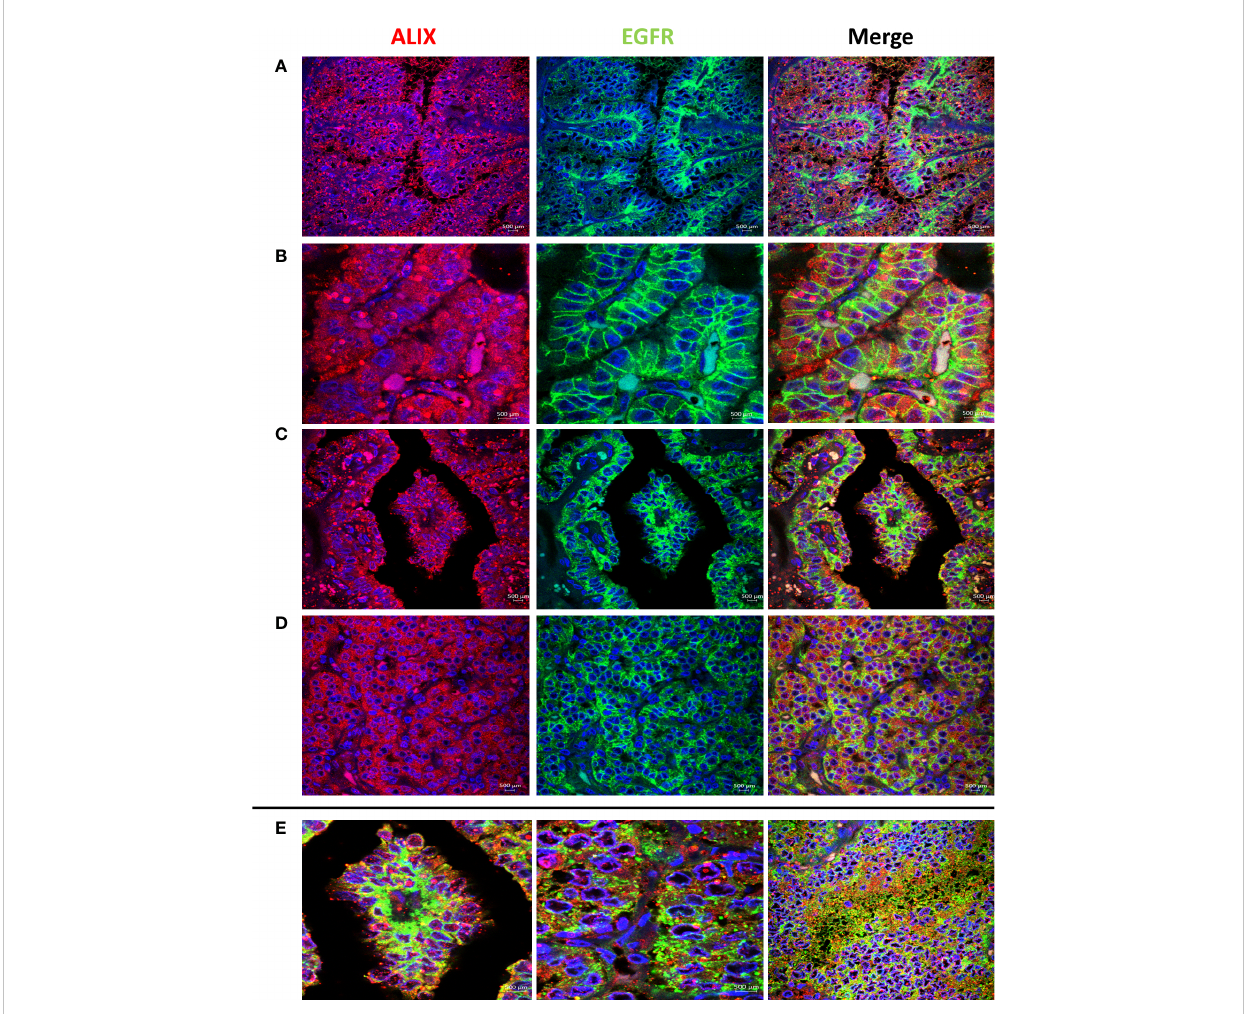
FIGURE 2 Representative samples stained with ALIX (red) and EGFR (green). Prominent ALIX positive vesicles of multiple sizes are seen in PTC in association with EGFR cytoplasmic expression (A) , EGFR membranous expression (B) , and EGFR enrichment at the basolateral surfaces (C) . (D) ALIX and EGFR expression in NIFTP sample. (E) Colocalization of ALIX and EGFR in intracellular and extracellular vesicles in PTC (Colocalization coef fi cient >